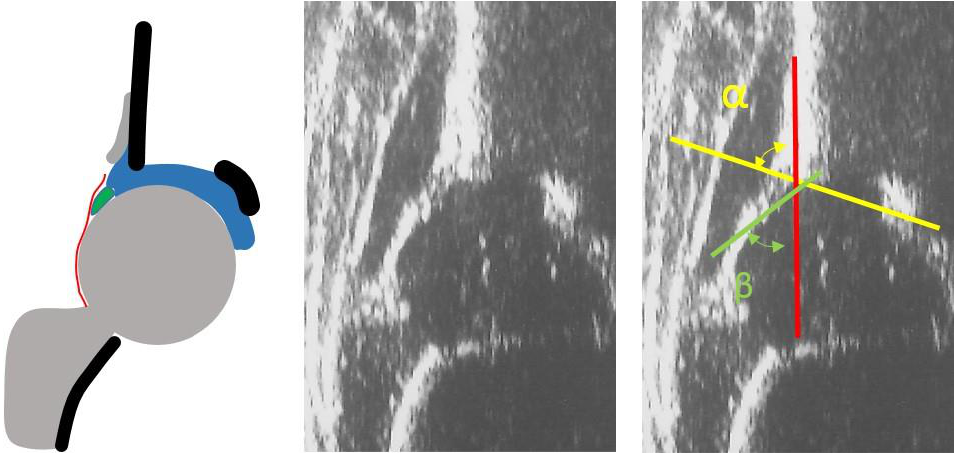
Figure 1. Normal newborn hip. Ultrasound (US) and diagram showing a type I according to